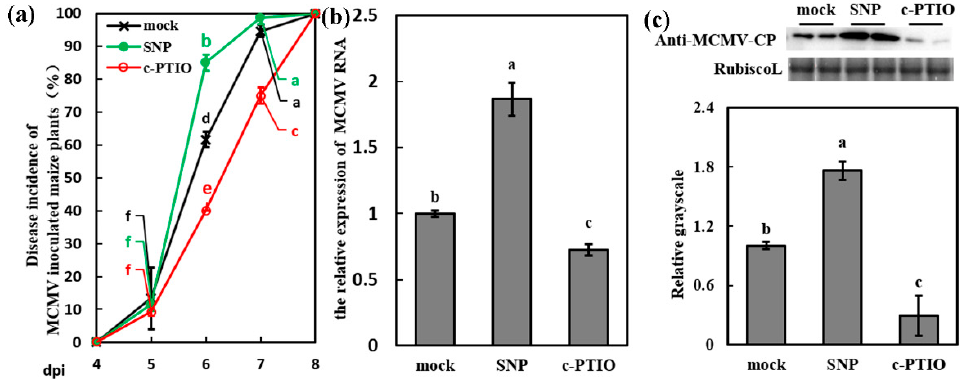
Figure 5. NO induced the susceptibility of maize to MCMV infection. ( a ) Disease incidence (%) of MCMV-inoculated maize plants after application of Tween-20 (0.02%, mock), SNP (200 µ M), and c-PTIO (200 µ M) with three independent replicates. Significant di ff erences between di ff erent treatments (mock, SNP and c-PTIO) in the same dpi were indicated in lowercase letters. ( b ) RT-qPCR analysis of the MCMV RNA accumulation after application of Tween-20 (0.02%, mock), SNP (200 µ M), and c-PTIO (200 µ M). ( c ) Representative western blot showing MCMV accumulation after application of Tween-20 (0.02%, mock), SNP (200 µ M), and c-PTIO (200 µ M). The grayscales of immunoblotting bands were determined by ImageJ. Graphs represent the relative MCMV accumulation through quantifications of three independent experiments with at least three plants per experiment. Statistical analysis was performed using SPSS 16.0 followed by ANOVA with LSD test at the level of p -value ≤ 0.05. Significant di ff erence between di ff erent samples was indicated in lowercase letters.